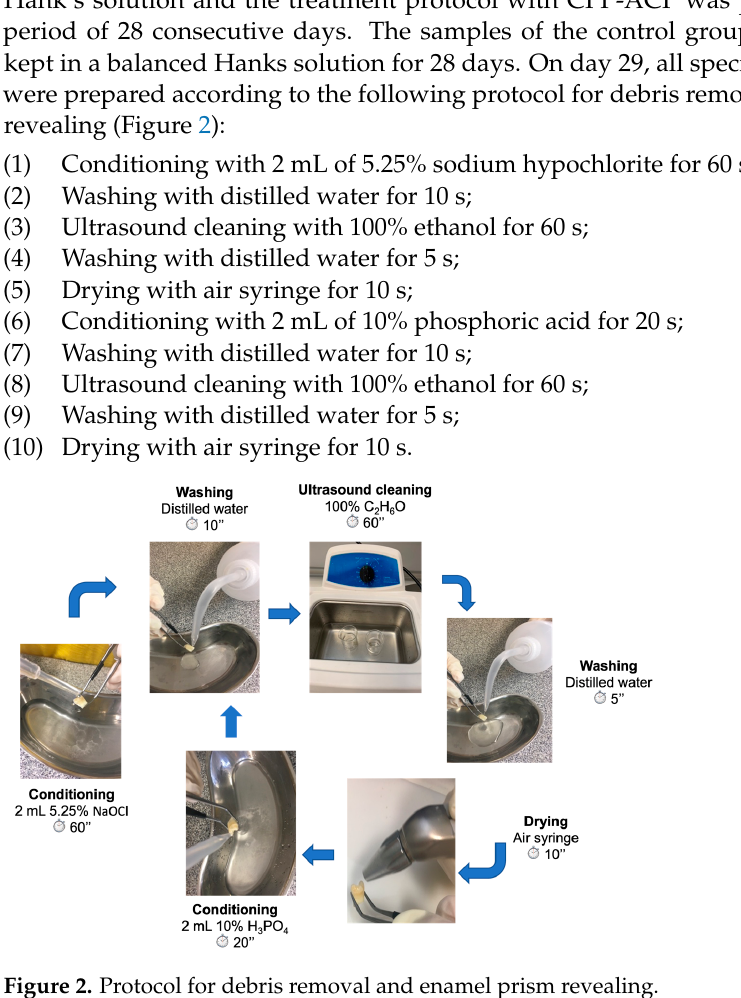
Figure 2. Protocol for debris removal and enamel prism revealing.